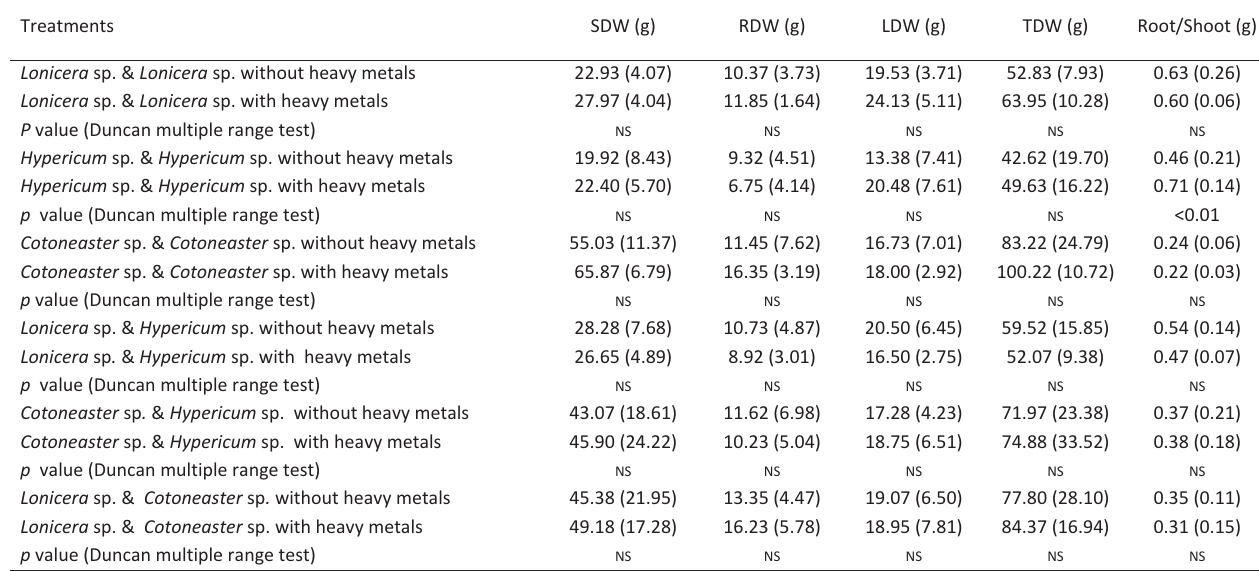
Table 3 ­ Effect of heavy metals on stem dry weight (SDW), root dry weight (RDW) leaf dry weight (LDW), total dry weight (TDW) and